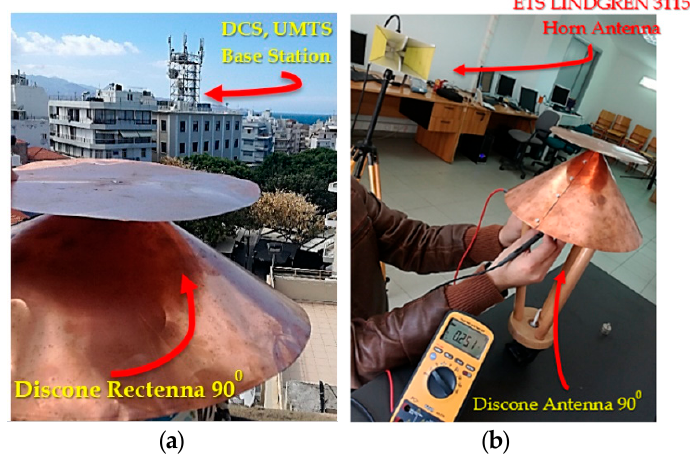
Figure 5. ( a ) The broadband Discone rectenna experiment setup nearby a base station in the urban environment, at Heraklion, Crete, Greece and ( b ) testing at the N.I.R.L laboratory of the Hellenic Mediterranean University